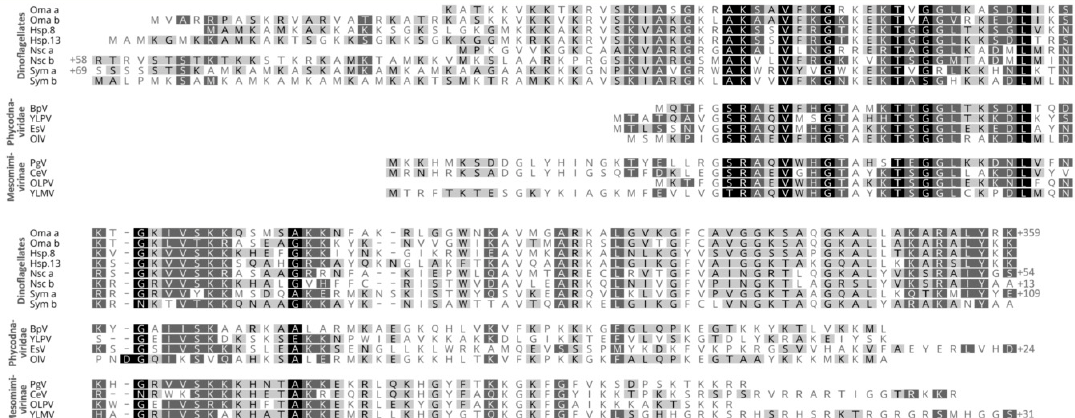
Figure 2. Sequence alignment of dinoflagellate / viral neucleoproteins (DVNPs) from selected species of dinoflagellates, Phycodnaviridae, and the newly proposed Mesomimivirinae. Oma = Oxyrrhis marina ; Hsp = Hematodinium sp.; Nsc = Noctiluca scintillans ; Sym = Breviolum (Symbiodinium) minutum ; BpV = Bathycoccus sp. virus; YLPV = Yellowstone Lake phycodnavirus; OlV = Ostreococcus lucimarinus virus; PgV = Phaeocystis globosa virus; CeV = Chrysochromulina ericina virus; OLPV = Organic Lake phycodnavirus; YLMV = Yellowstone Lake mimivirus.